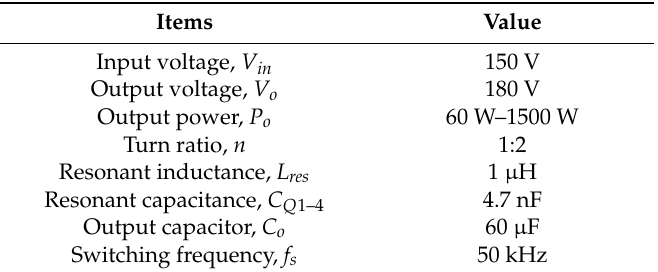
Table 3. Parameters of the two converters for the performance